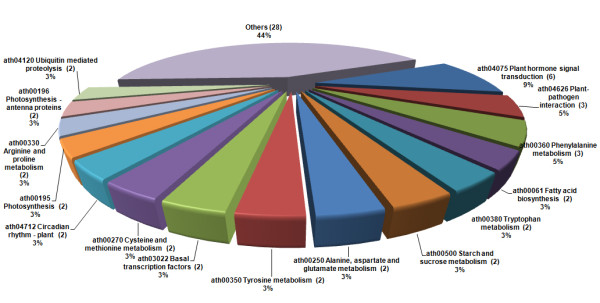
KEGG pathway maps of cold-responsive genes. A total of 44 pathways were identified through KEGG mapping. Different colors represent the pathway entries and pathway names. The number of genes represented by AGI loci involved in each pathway is labeled in the parentheses.